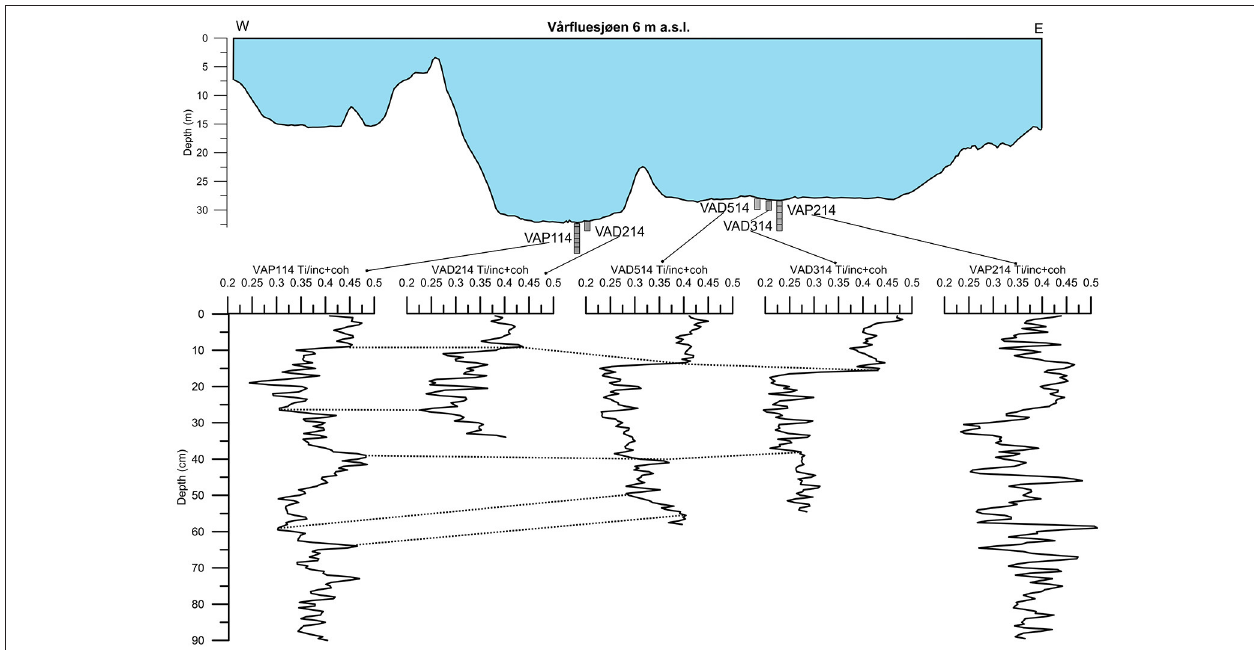
FIGURE 4 | Transect through the three basins of Vårfluesjøen from west to east (red line in Figure 2 ). The relative position of the piston cores (VAP) used in this study are plotted together with the gravity cores (VAD). The sediment cores are visually matched based on the Ti/inc + cohderived from the ITRAX XRF scanner. The dotted lines between the different cores indicate correlation between the different cores derived from Vårfluesjøen. Based on this, it is suggested that the piston core VAP114 holds the most complete sediment